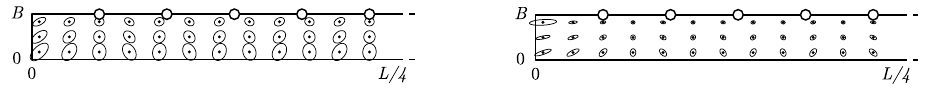
Figure 19. Representation of the (horizontally projected) random measurement error covariance matrix of the static camera setup for a quarter of the bridge deck for (top) mono and (bottom) stereo vision: 95% confidence regions (lines) for different locations on the bridge deck (dots). The confidence regions are rescaled with a factor 3 around the true locations for illustration purposes.